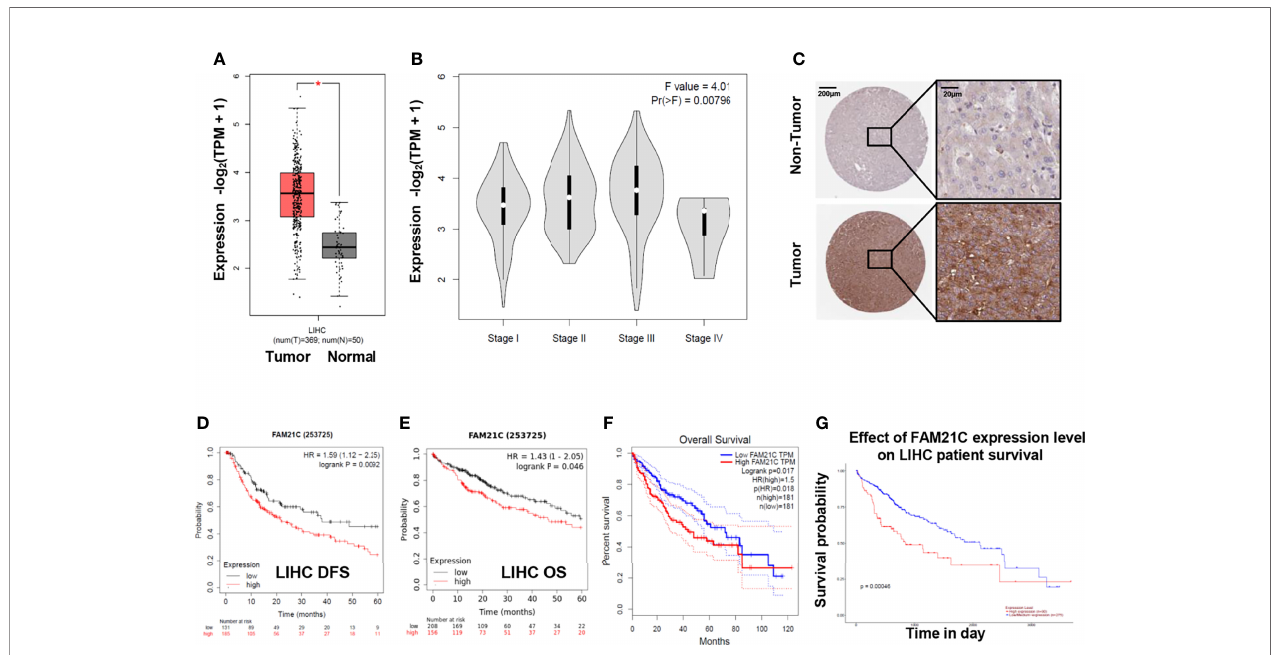
FIGURE 1 | FAM21C increases in HCC and is an indicator a poor prognosis by bioinformatics analysis. (A) The differential analysis of mRNA levels of FAM21C between 369 HCC tissue and 50 normal tissues. (B) Relationship between FAM21C mRNA expression levels and the HCC clinical stages in GEPIA datasets. (C) The protein level of FAM21C in HCC tissue and non-tumor tissues using the Human Protein Atlas (HPA) database. Representative pictures are shown. (D, E) DFS and OS of FAM21C in Kaplan – Meier Plotter database using the “ Auto select best cutoff ” option. (F, G) The OS of FAM21C in GEPIA and Ualcan database respectively. Survival analysis showed that high expression of FAM21C mRNA indicated a poor survival time. * P < 0.05 was considered statistically signi fi